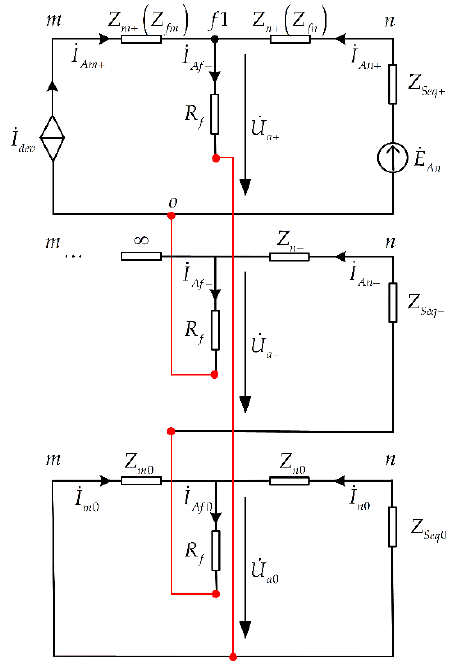
Figure 12. Compound sequence network under a phase-A-to-ground fault at f1.